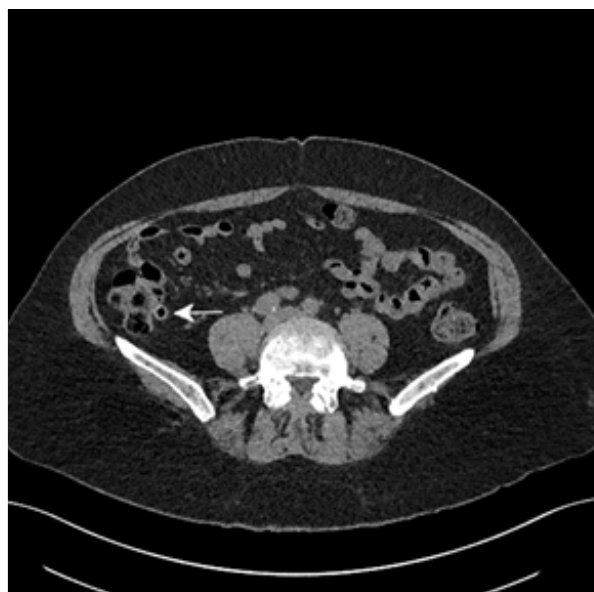
Figure 1. Axial view of the caecum with multiple diverticulae, one of which has a dense wall (white arrow).